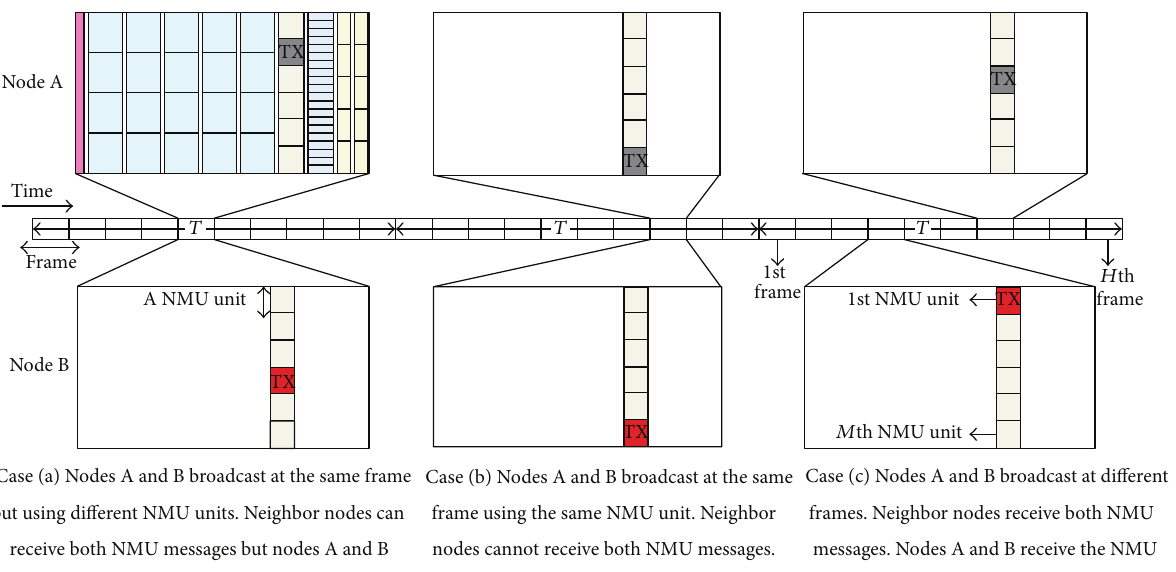
Figure 2: During time period 𝑇 , each node selects a frame randomly among the frames within 𝑇 and chooses an NMU channel in the frame at random to broadcast its presence to its 1-hop